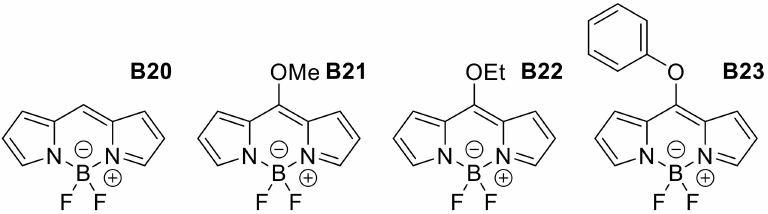
Figure A5. Alkoxy groups placed at the meso position.